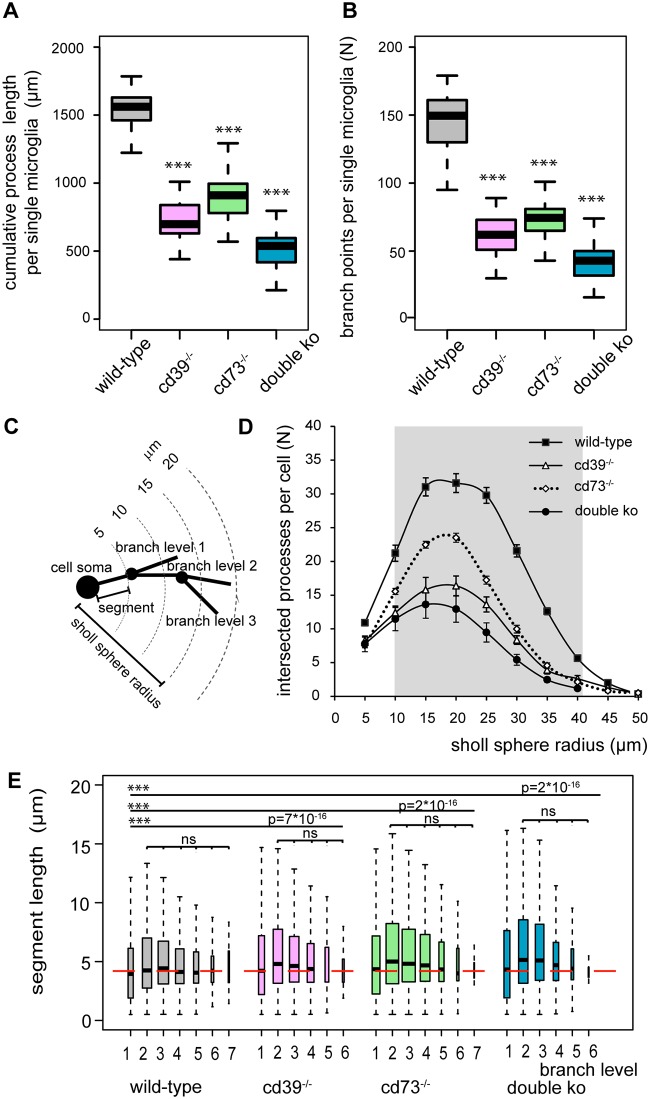
Quantification of 3-dimensional microglial process ramification shows that microglia from adult (P56) cd39-/-, cd73-/-, and double knockout mice have a less complex morphology in the somatosensory cortex compared to those from wild-type mice.Individual microglial cells from wild-type (grey, N = 46), cd39-/- (pink, N = 46), cd73-/- (green, N = 70) and double knockout (cd39-/-/cd73-/-) (blue, N = 128) mice were analyzed using Imaris 6.7.4; N represents the number of individual cells. Box plots show that cumulative processes length (A) was shorter with a fewer number of branch points (B) in the knockout microglia. C is a scheme to illustrate the Sholl analysis. The number of processes intersecting concentric rings every 5 μm is shown in D. The grey area marks the Sholl sphere radius where a significant (p < 0.001) reduction in the number of Sholl intersections in knockout microglia in comparison to wild-type microglia was found. (E) Box plots show the length of individual segments for each branch level (1 to 6) of wild-type (grey, N = 13650), cd39-/- (pink, N = 5709), cd73-/- (green, N = 10740) and double knockout (blue, N = 11778) microglial cells. In each box plot, the bar demarks the median, the box demarks the range from 25% to 75% of the data, and the dotted lines indicate the entire range of data. N represents the number of analyzed segments. The depth of process branching (branch level) was reduced whereas the length of individual segments was increased in knockout mice; the red dashed line shows the median of the segment length in wild-type microglia. ns denotes p > 0.5 and *** denotes p < 0.001.